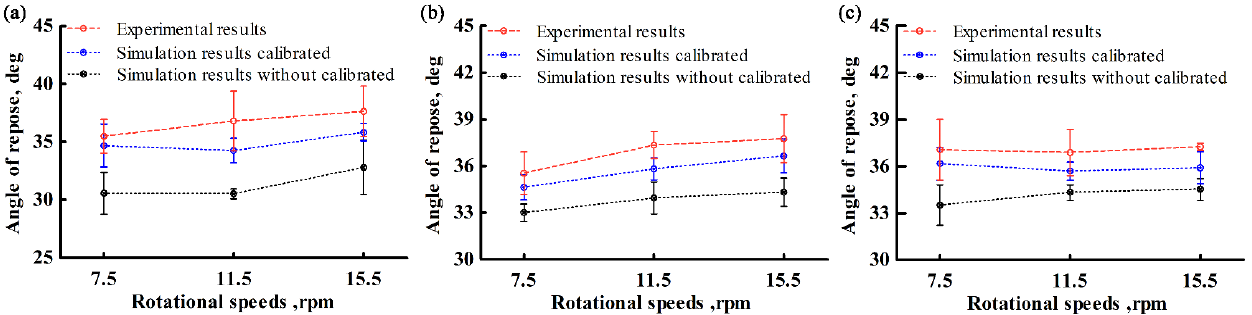
Figure 19. The relationship between dynamic angle of repose and rotational speed for ( a ) SN42, ( b ) JD17, and ( c ) ZD39.